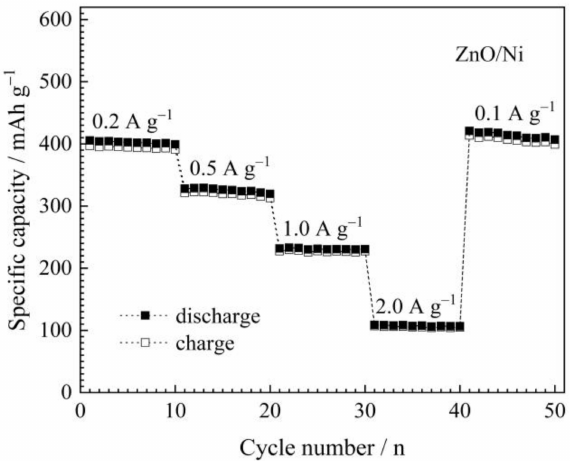
Figure 5. The evolution of ( a ) capacity and ( b ) coulombic e ffi ciency during the cycling process of the two electrodes.